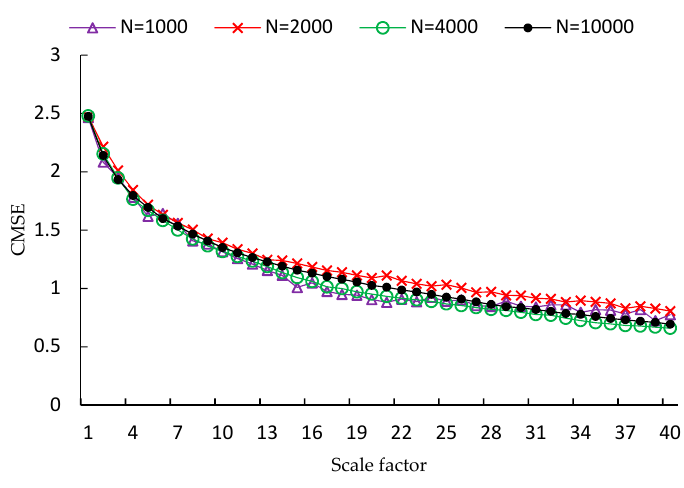
Figure 3. CMSE values for white noise signals with different lengths.